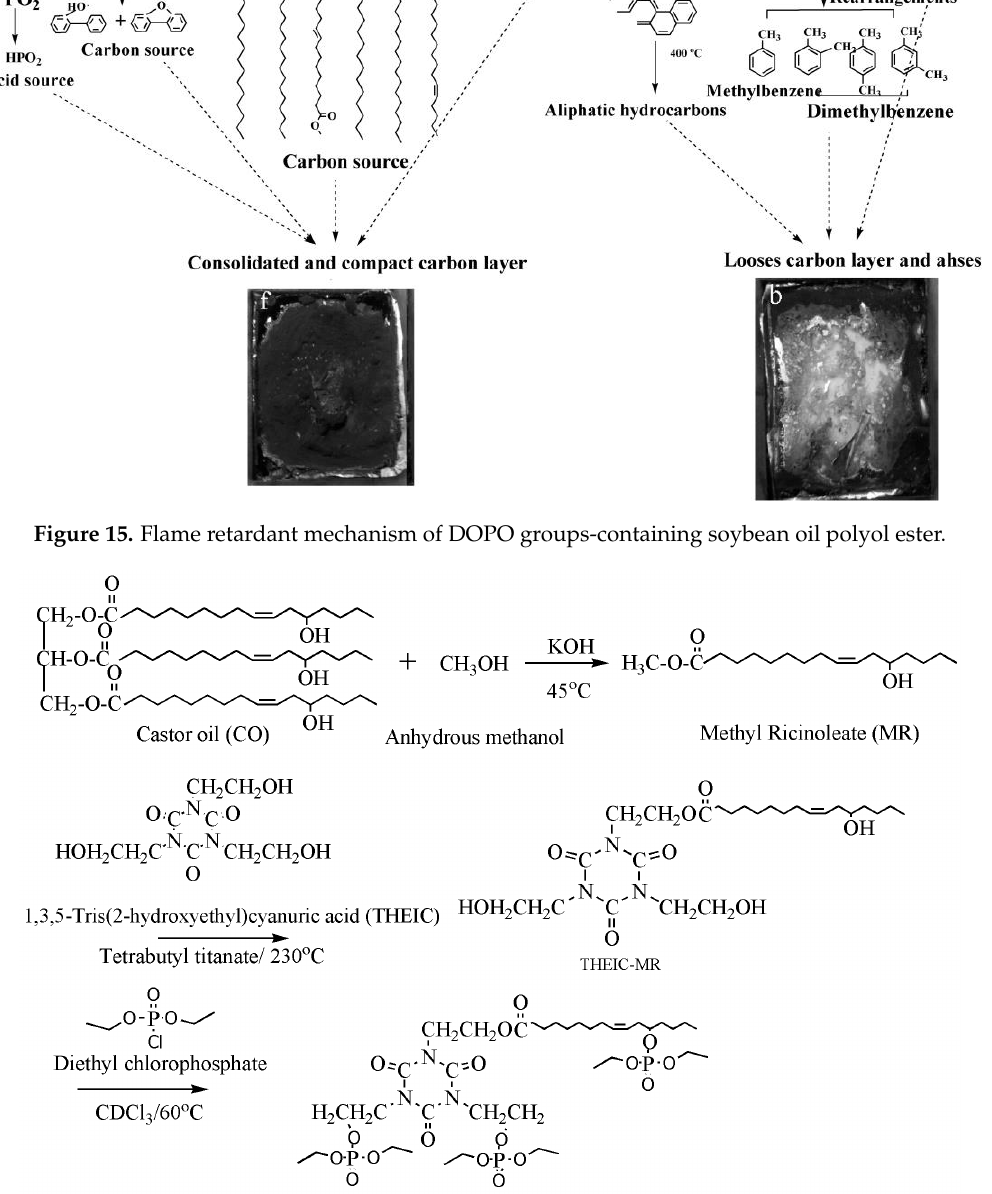
Polymers 2018 , 10 , x FOR PEER REVIEW